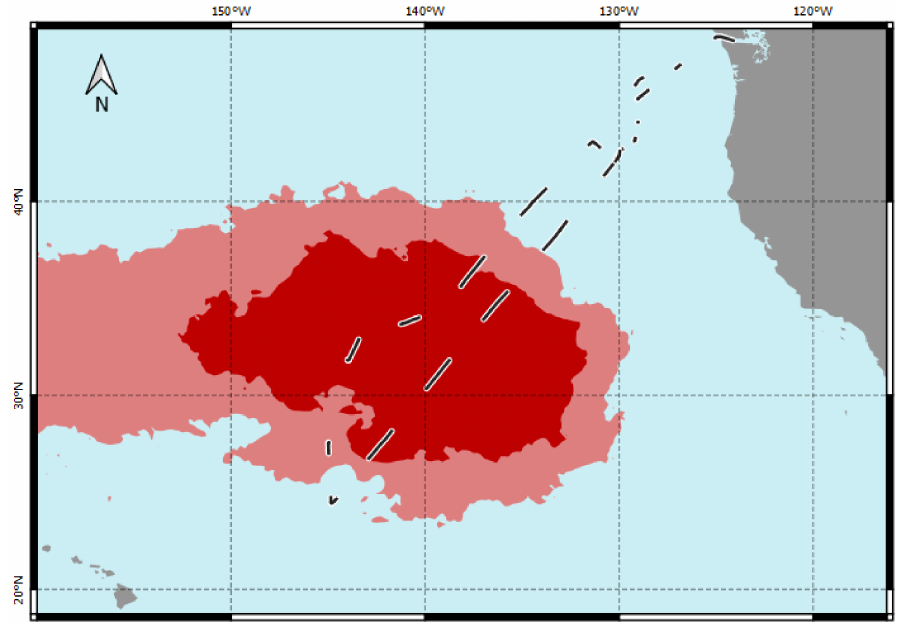
Figure 2. Map of the photo footprints (black lines) during mission NPM3. The gaps are mainly caused by transit during nighttime, at which no photos were recorded. The light and dark red shaded polygons indicate the estimated outer and inner areas of the Great Pacific Garbage Patch (GPGP), respectively